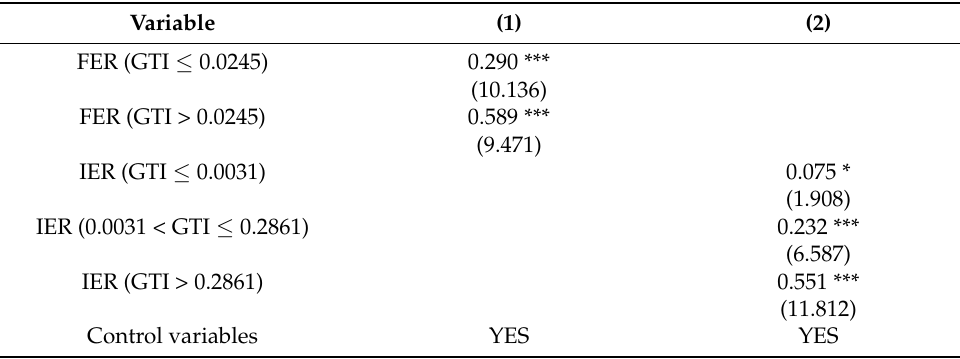
Table 11. The estimation results of the threshold-regression